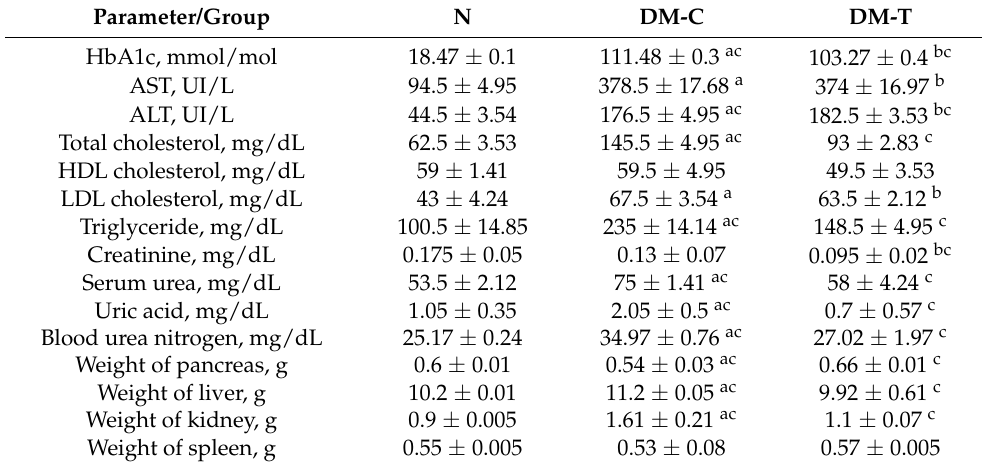
Table 2. Quantitative biochemical parameter levels in experimental rats and mean weights of pancreas, liver, pancreas, and spleen at sacrificial time in experimental animals. Data are expressed as mean ± SD ( n = 6/group). Statistical significance of DM-C vs. N group ( a , p < 0.05), DM-T vs. N group ( b , p < 0.05), and DM-C vs. DM-T group ( c , p <